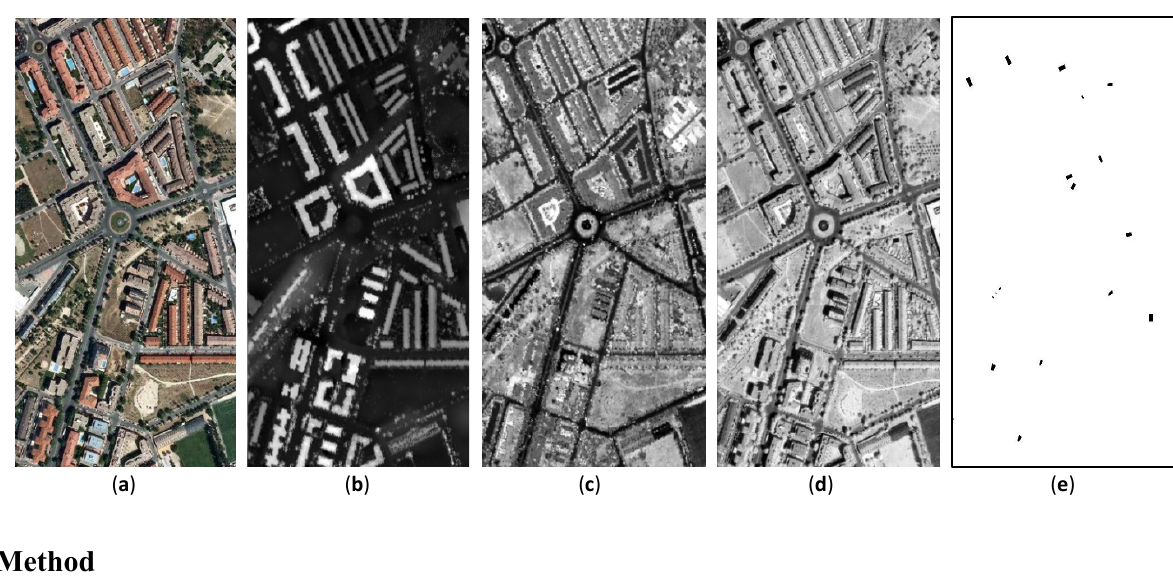
Figure 1. ( a ) Aerial RGB image; ( b ) digital surface model (DSM); ( c ) intensity LIDAR data; ( d ) near-infrared band from the aerial image; and ( e ) the ground truth made by the authors to determine the accuracy of each studied